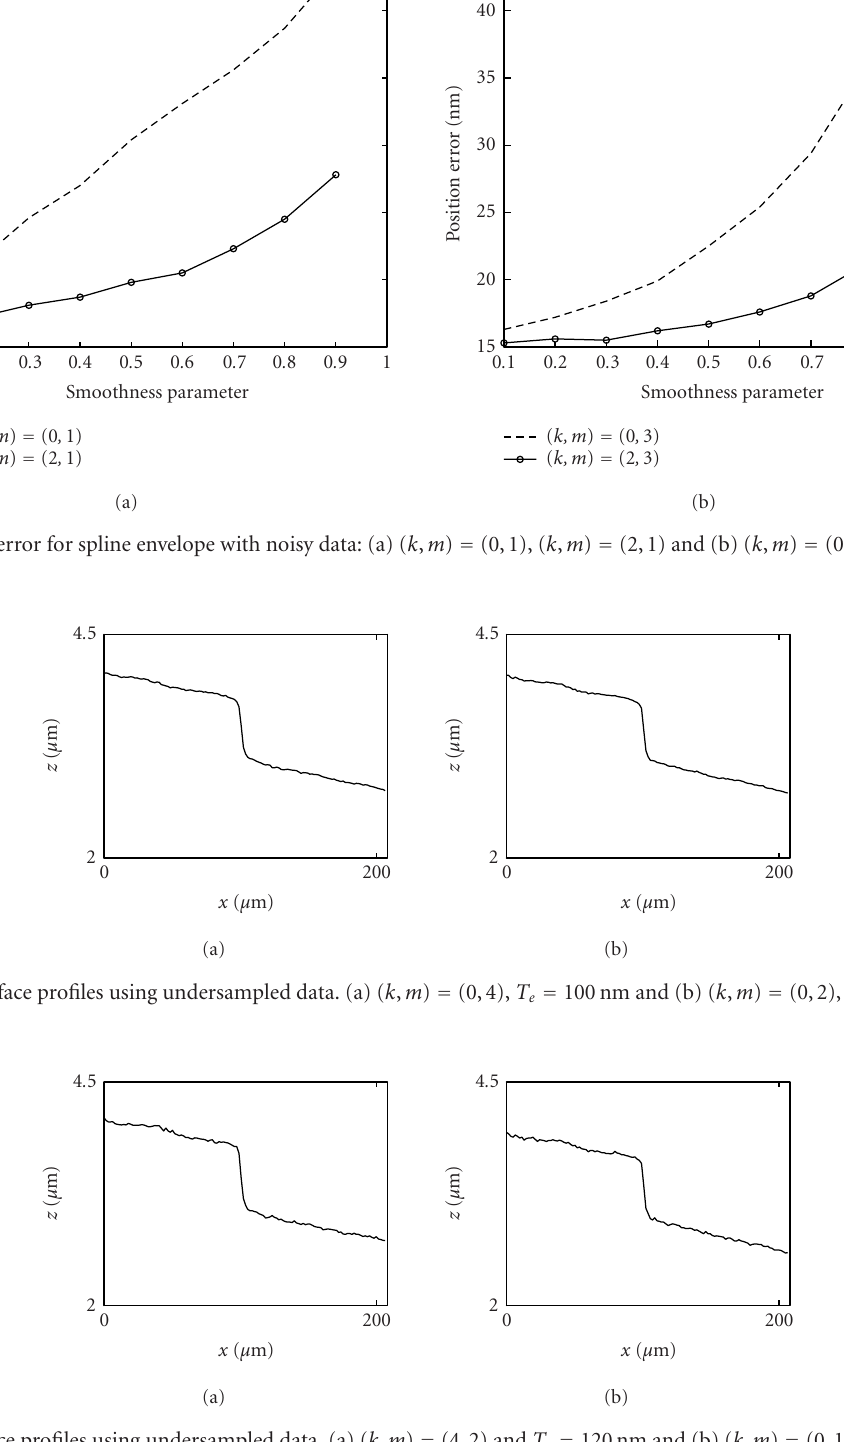
operators generalize the FSA technique. Secondly, instead of using only an approach based on a Gaussian assumption to extract the envelope, the cubic splines based on distance